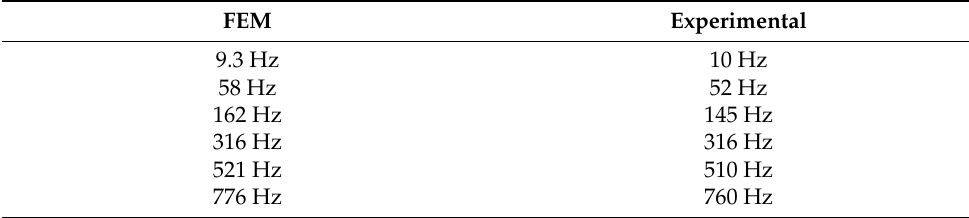
Table 2. Comparison between numerically predicted and experimentally determined flexural reso- nance frequencies of the composite